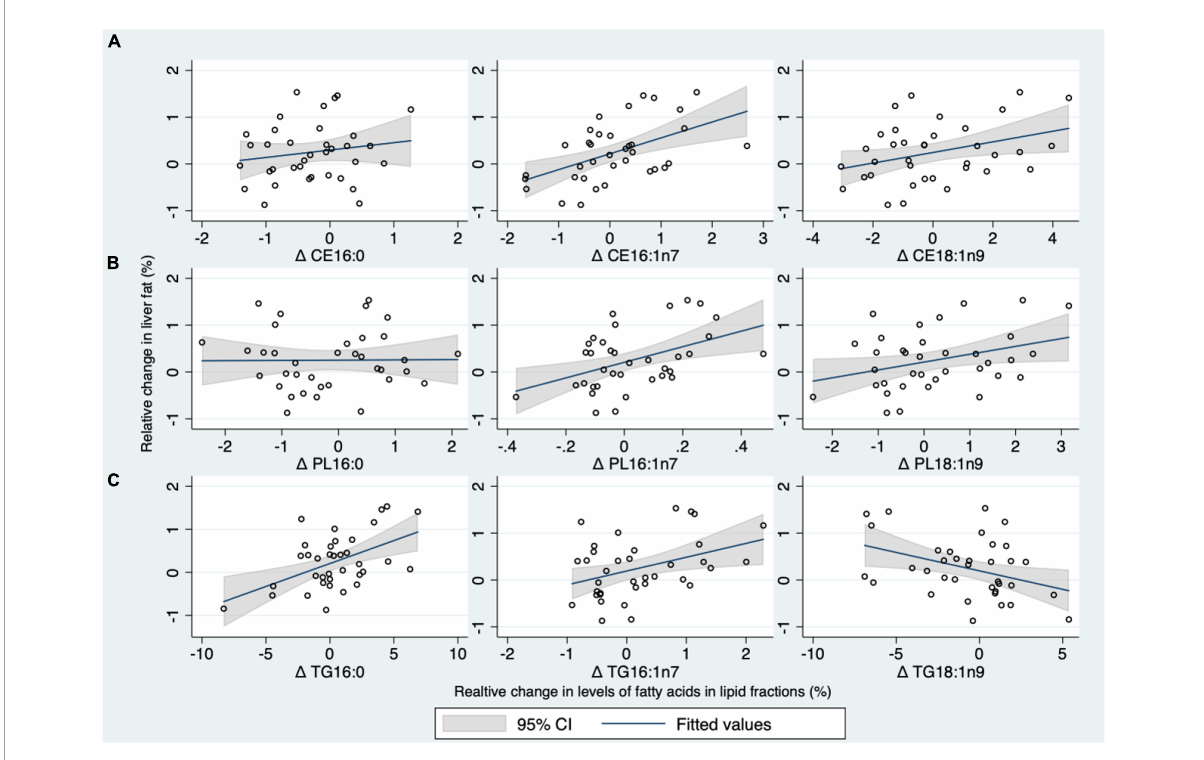
FIGURE3 (A–C) Scatterplots of correlation of the relative changes (i.e., percentage points) in plasma palmitate (16:0), palmitoleate (16:1n7), oleate (18:1n9) in phospholipids (PL), cholesteryl esters (CE), and triglycerides (TG) lipid fractions with the relative changes in liver fat content after 24 weeks intervention in the whole population. The correlation of relative changes in plasma (16:0, 16:1n7, and 18:1n9) in the CE fraction with relative changes in liver fat content (A) , The correlation of relative changes in plasma (16:0, 16:1n7, and 18:1n9) in the PL fraction with relative changes in liver fat content (B) , and the correlation of relative changes in plasma (16:0, 16:1n7, and 18:1n9) in the TG fraction with relative changes in liver fat content (C)